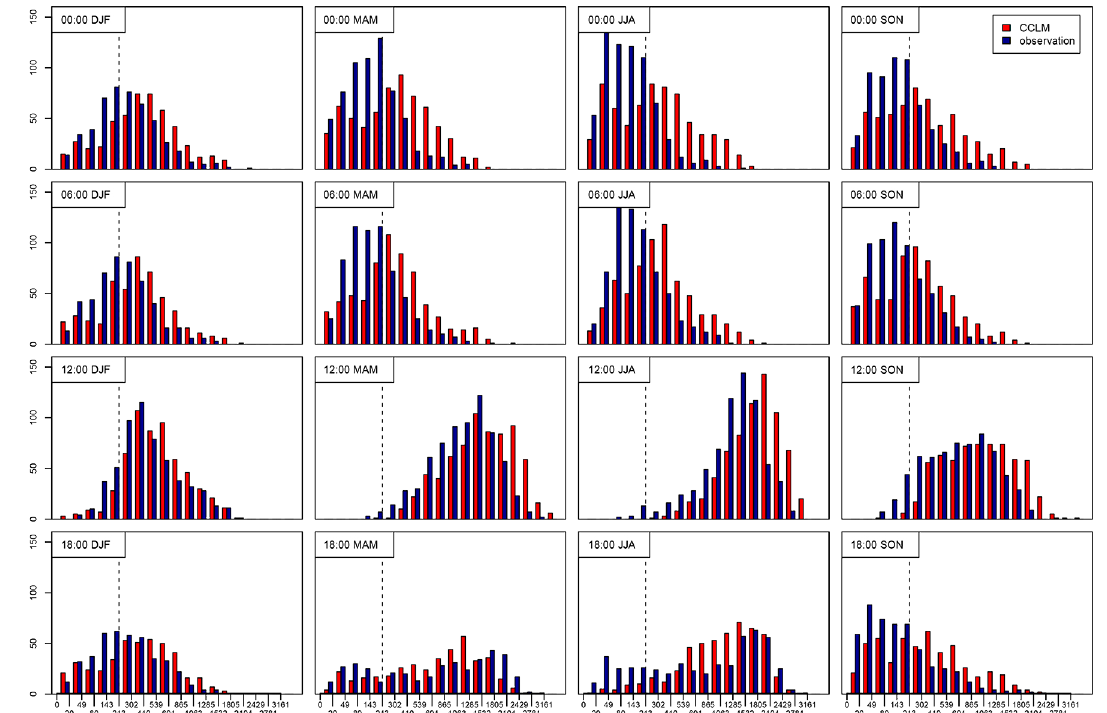
Figure 12. Frequency distribution of the planetary boundary layer height [m] of coastDat2-CCLM and observation from 2003 to 2012.